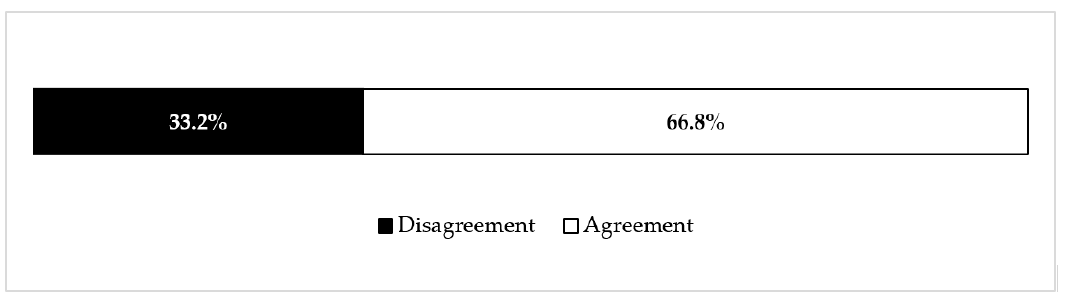
Figure 1. Responders’ vaccination attitude (%).